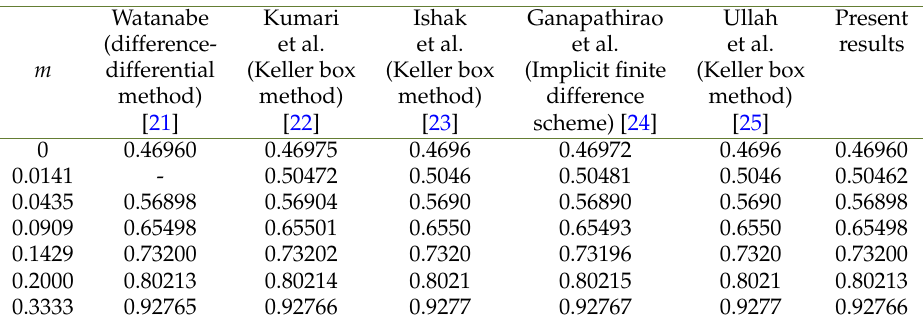
Table 2. Skin friction coefficient for different values of m with Pr= 0.73, K = A = γ = 0, where λ = 2 m /( m + 1)